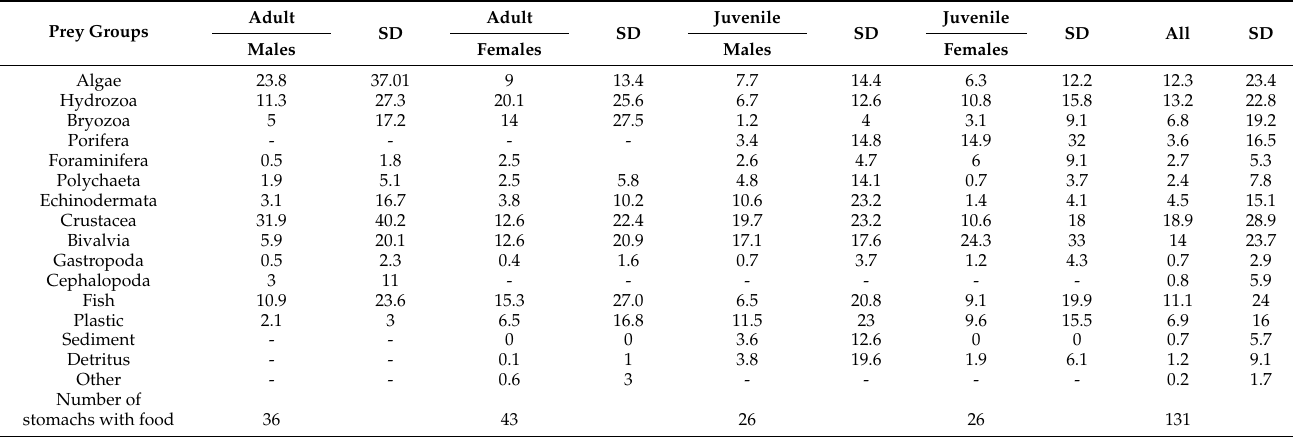
Table 2. Mean volumetric contribution (%) of food items in the diet of Lithodes santolla among sex and maturity stage, Nassau Bay, Cape Horn.